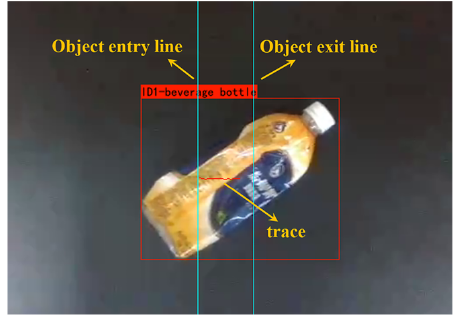
Figure 11. Plastic tracking.